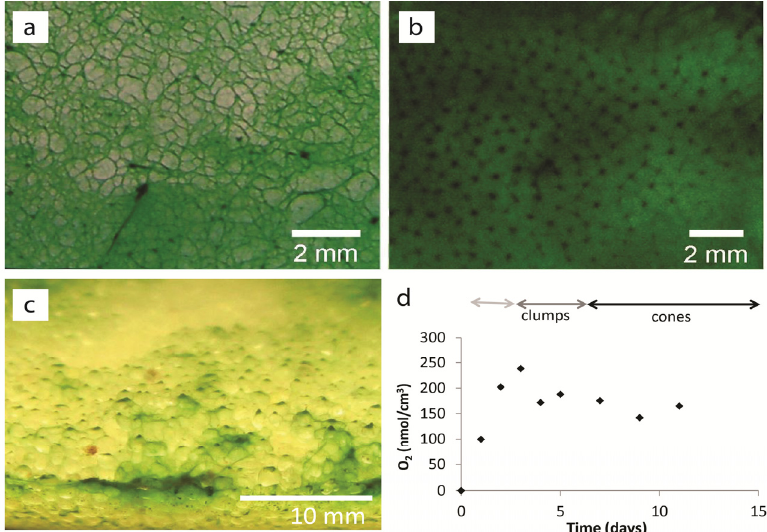
Figure 2. Growth of clumped mats. ( a ) In the initially anaerobic media, flat and ridged mats develop before the onset of clumping (photograph); ( b ) Thicker, clumped mats develop from the flat mats shown in ( a ) (photograph); ( c ) Clumps on tops of silica sand grains (0.5 mm diameter). This mat grew in a solution initially equilibrated with air; ( d ) Oxygen concentration in the growth medium during the transition from flat to clumped and, ultimately, coniform mats. The onset of clumping coincides with a decrease in the accumulation of oxygen. Oxygen concentration in the solution above the mat does not change during the continued growth of small cones, such as those shown in Figure 1F. The system was open to gas exchange, so a constant oxygen concentration does not indicate that the culture is not net photosynthetic. Instead, the oxygen production is in equilibrium with the diffusion of oxygen out of the medium. This trend is representative of measurements in eight